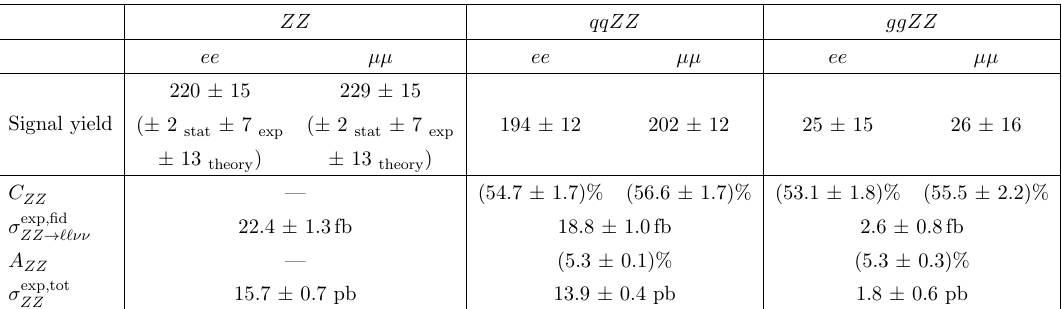
Table 4 . Predictions for the signal yields at detector level, for the C in eq. (1.1), and for the cross-sections in the (cid:12)ducial and total phase spaces. The (cid:12)rst column